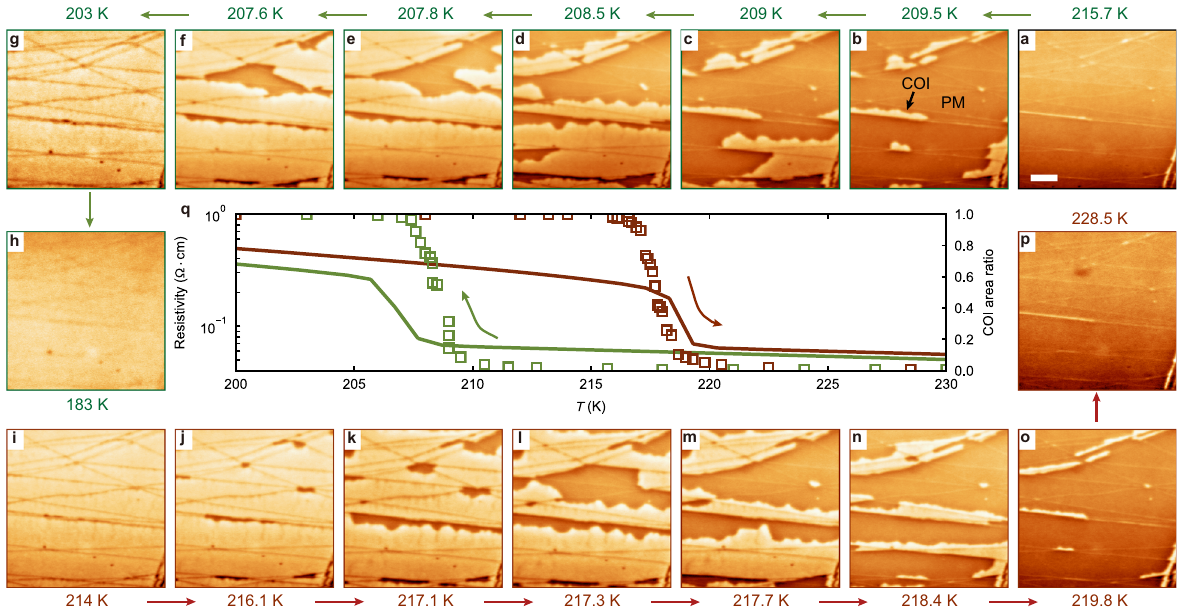
Fig. 2 Imaging the magnetic contrast at T COI . The magnetic images are taken on a rough region while the sample is cooled down from room temperature to 183 K ( a – h ) and then warmed up to 230 K ( i – p ) in a fi eld of 9 T. The arrows indicate the imaging sequence. q shows the temperature dependence of resistivity in 9 T (solid lines) and the area ratio of the charge-ordering insulating (COI) phase (open squares) extracted from the MFM images. Scale bar in a : 2 μ m. MFM image size: 11.8 × 11.8 μ m 2 . The contrast is ~0.5 Hz for all the